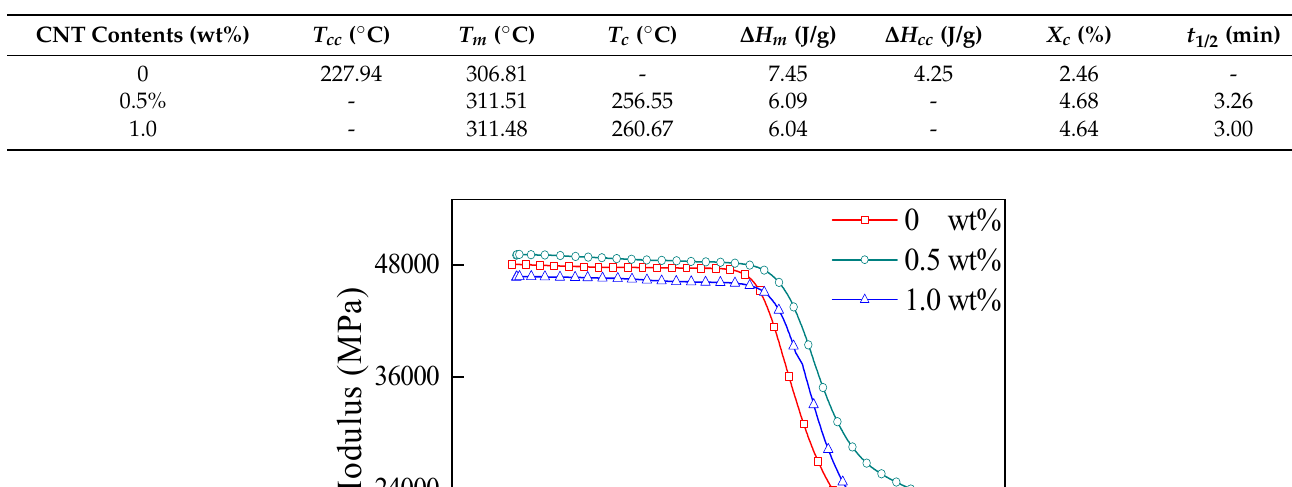
Table 1. T cc , T m , T c , ∆ H m , ∆ H cc , X c and t 1/2 of prepregs with different CNT contents.